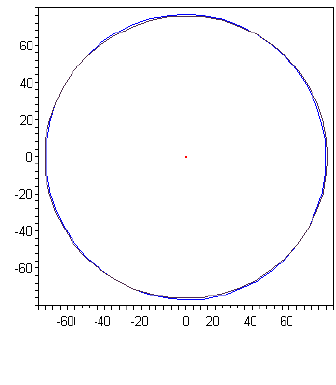
Figure 5. Directional diagrams of A in the centre